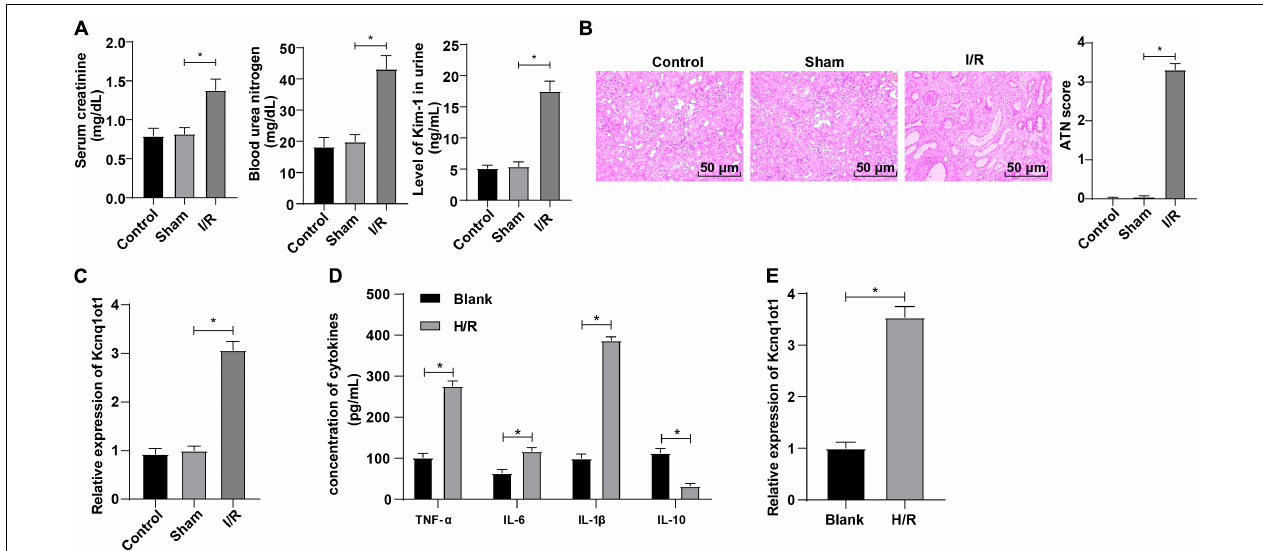
FIGURE 1 | LncRNA Kcnq1ot1 was highly expressed in mice with AKI. (A) Levels of SCr, BUN, and KIM-1 were detected by ELISA; (B) pathological changes of renal tissues were detected by HE staining and quantitative analysis of tissue damage was performed; (C) Kcnq1ot1 expression in renal tissues was detected by RT-qPCR; (D) levels of TNF- α , IL-6, IL-1 β , and IL-10 in the supernatants were detected by ELISA; (E) Kcnq1ot1 expression in H/R model of HK-2 cells was detected by RT-qPCR. All data in this figure were measurement data and presented as M ± SD . Comparison between two groups was analyzed using an independent sample t -test. * P < 0.05. The experiment was repeated three